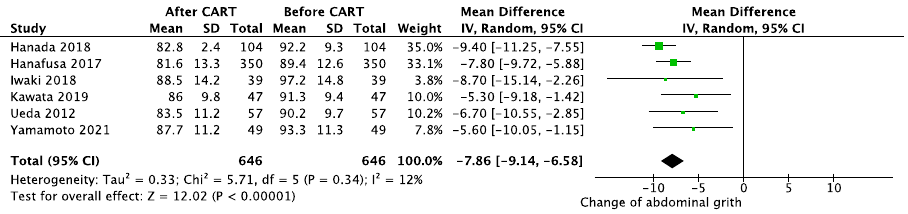
Figure 3. Change in serum albumin before and after CART. An improvement in PS was reported by 10 studies. Due to different evaluation meth- ods, only four studies were included in the meta-analysis, showing that 17% (95%CI 3– 31%) of the patients had improved PS after CART [24,26,27,29] (Supplementary Figure S10). Most studies also described the alleviation of symptoms after CART, with abdominal distension, dyspnea, and fatigue improved 6.0 (95%CI 5.59–6.51), 2.66 (95%CI 2.05–3.28), and 2.64 (95%CI 1.86–3.42) points using a numerical rating scale system ranging from 0 to 10 (Table 2) [18,25]. Table 2. Effect of CART on the alleviation of symptoms using a numerical rating scale system (0– 10).